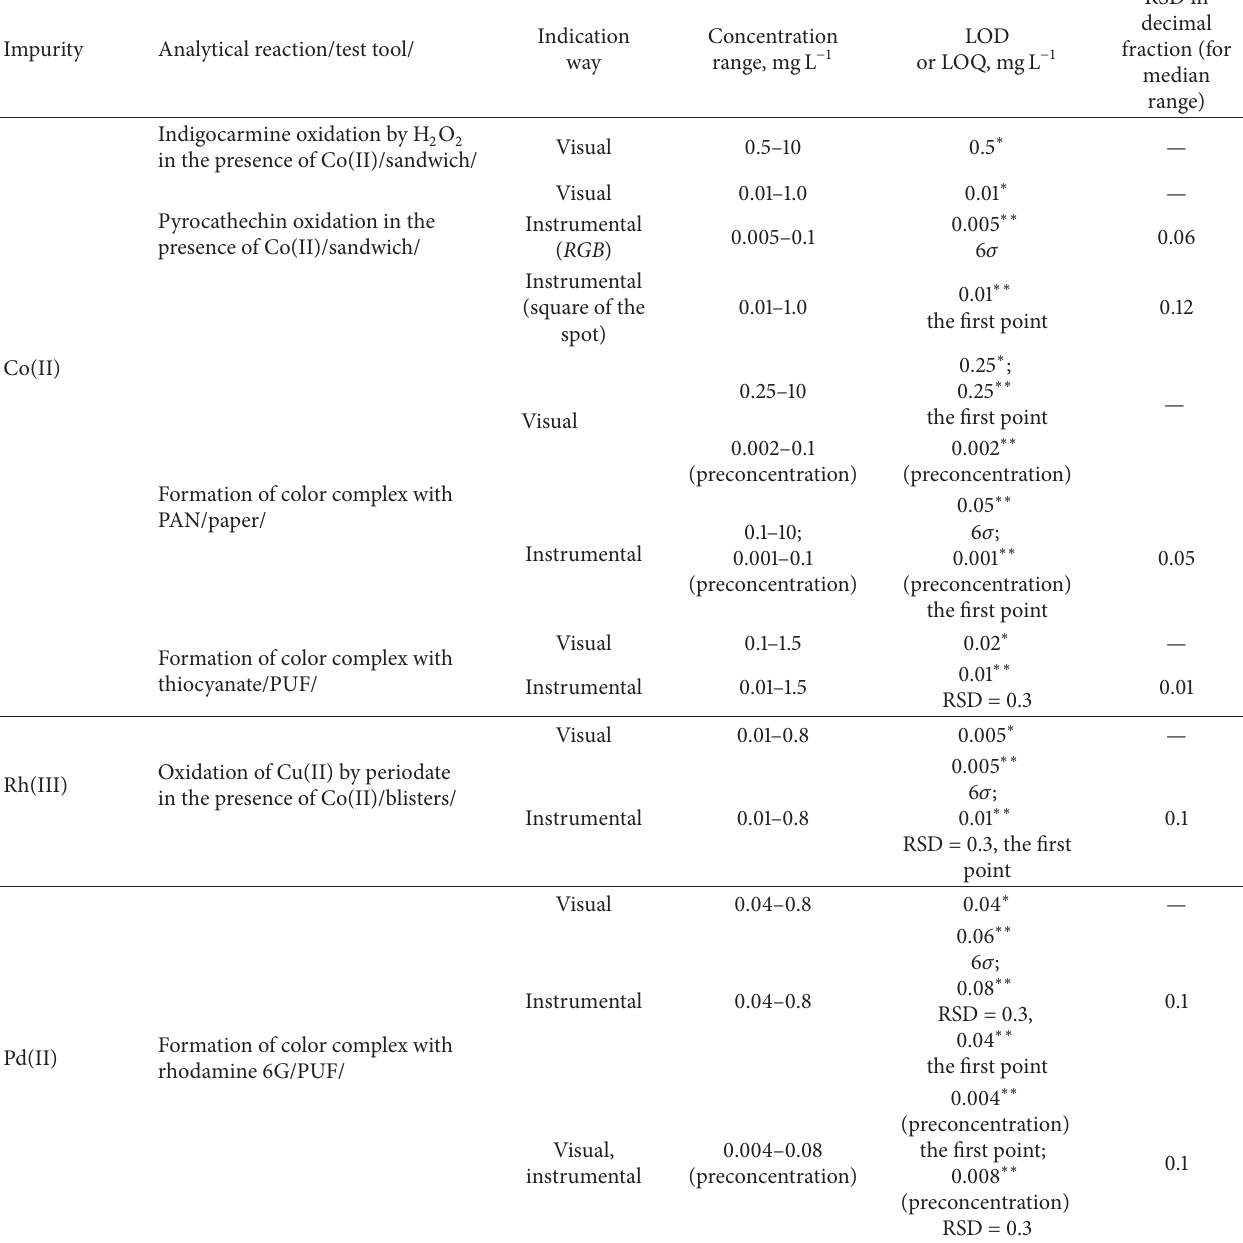
Table 2: The metrological characteristics of the developed tests for Co(II), Rh(III), and Pd(II).